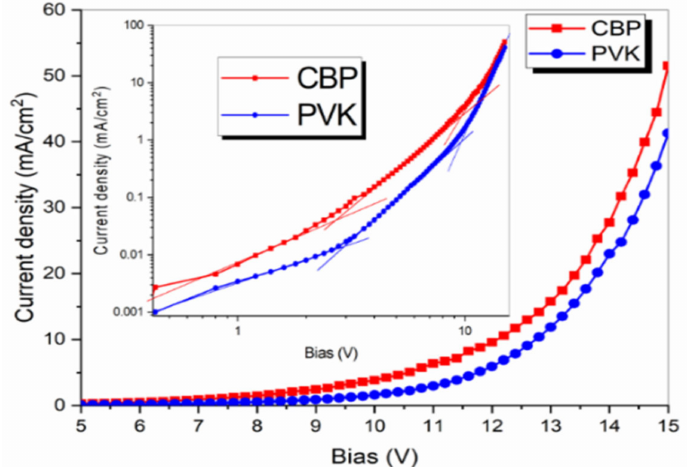
Figure 4. Current–voltage of IrQ(ppy) 2 based OLED in PVK and CBP (20%). Inlet, log–log I–V curves. 3.2. Current–Voltage Characteristics: Electroluminescence of IrQ(ppy) 2 in CBP Both types of OLED, with PVK and CBP, present a combination of the red and green electroluminescence, which comes from the two types of ligands. Figure 5a reveals the